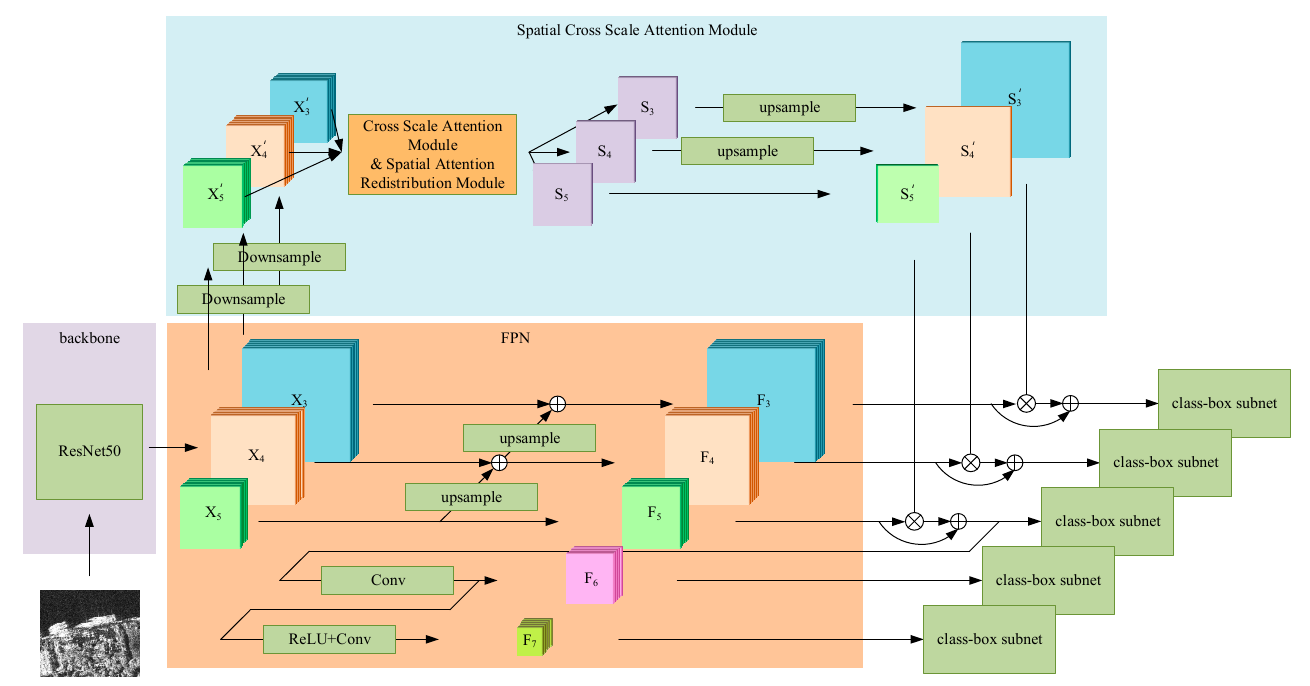
Figure 1. Overview of our proposed SCSA-Net. It consists of four sections: the backbone of the SCSA-Net, feature pyramid network (FPN), spatial cross-scale attention module, and class-box sub-net.